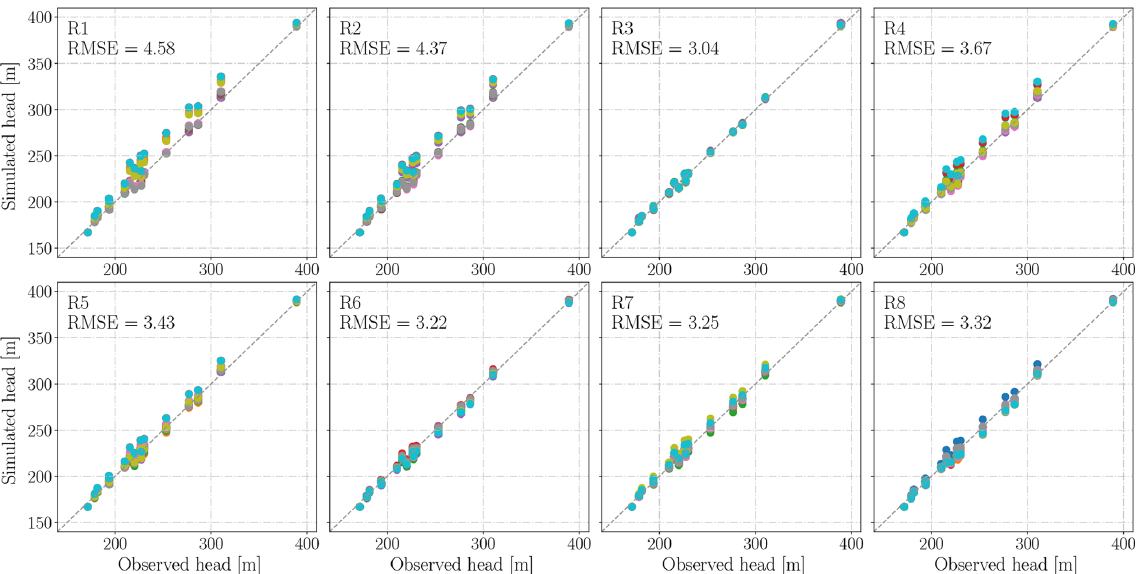
Figure 5. Observed and simulated groundwater heads for each parameter and recharge realization. The results of 400 realizations (R1K1– R8K50) are categorized by recharge realization and shown in different